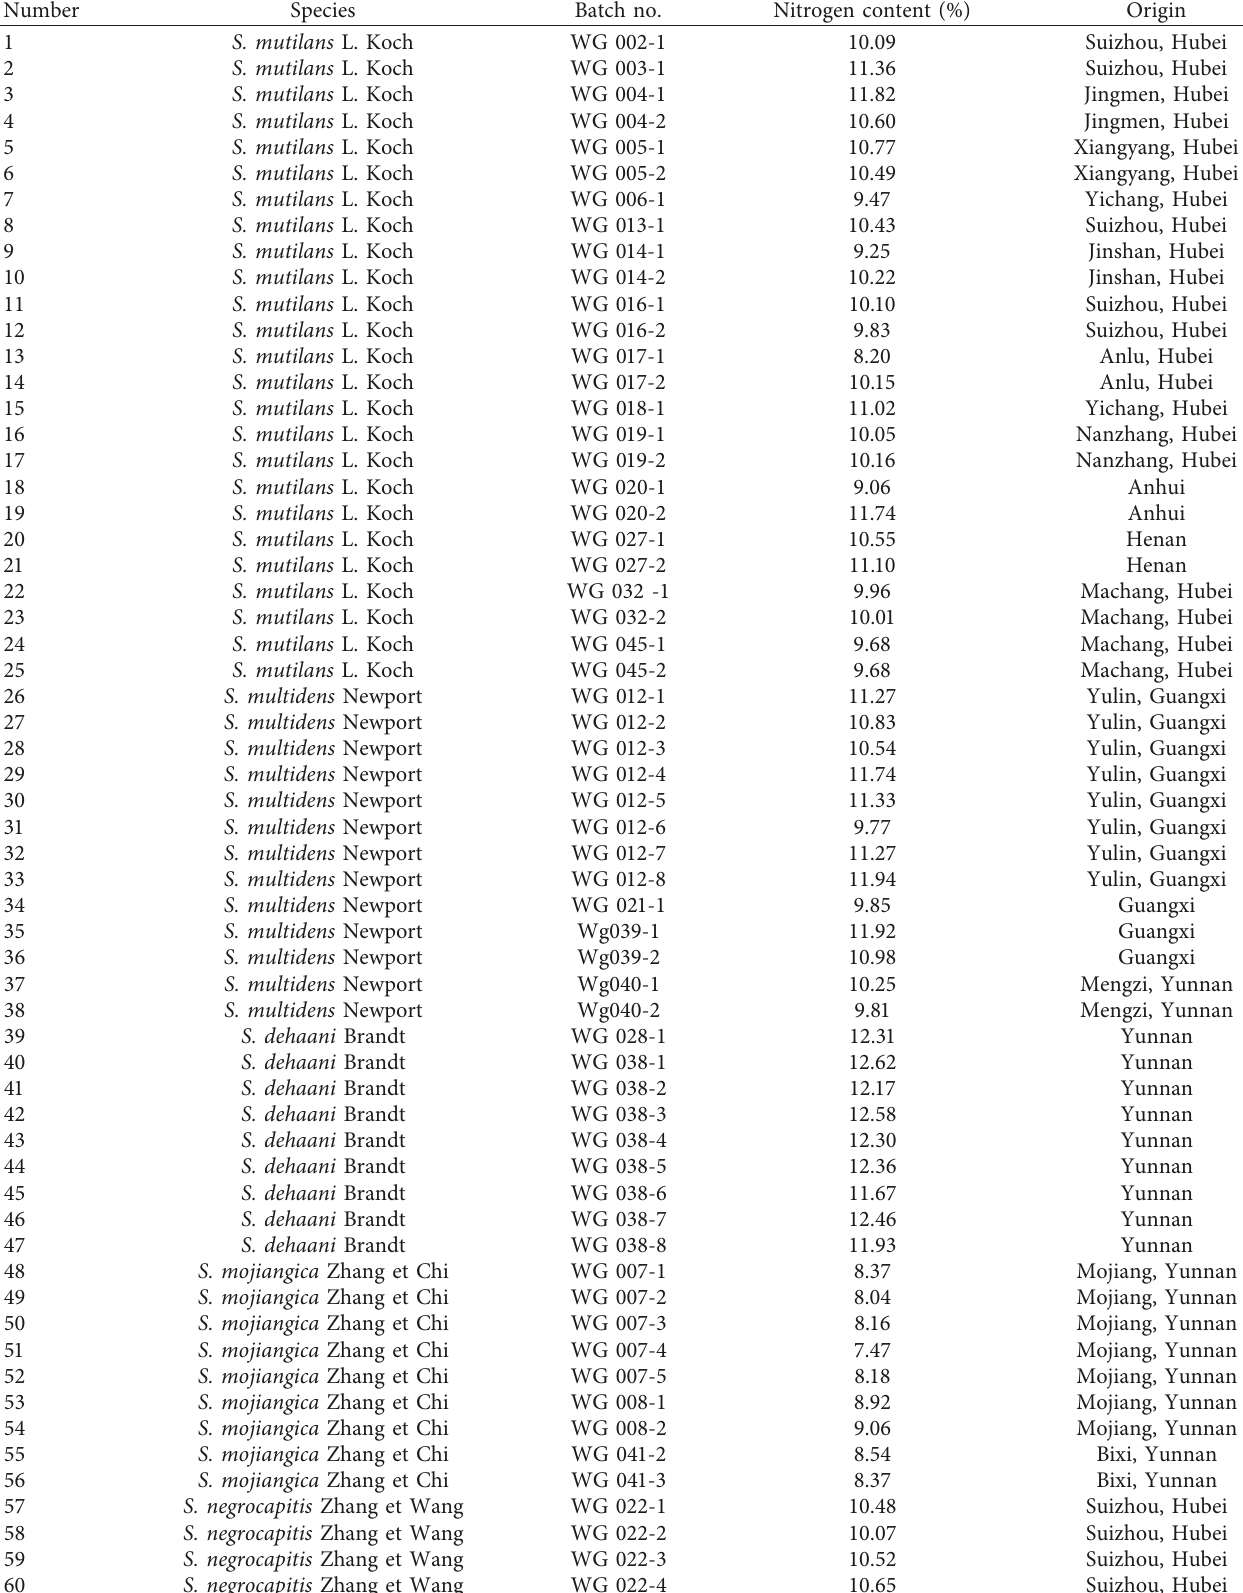
Table 1: Sample information of medicinal